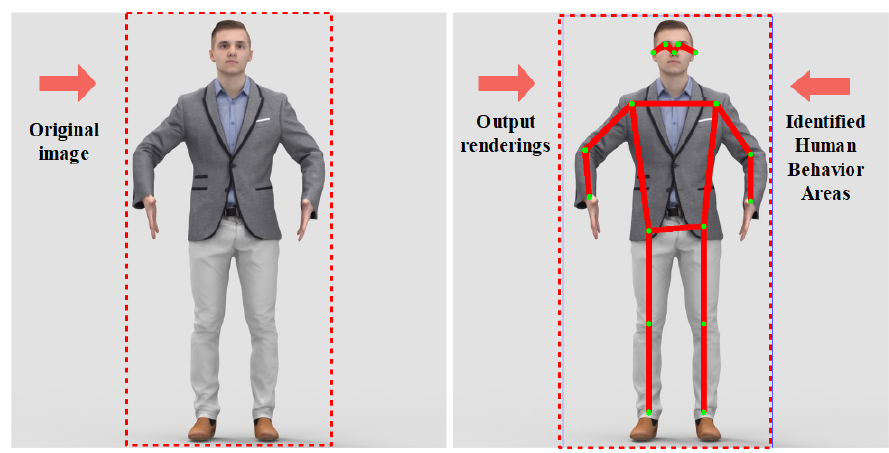
Figure 23. Schematic diagram of machine learning detection results.